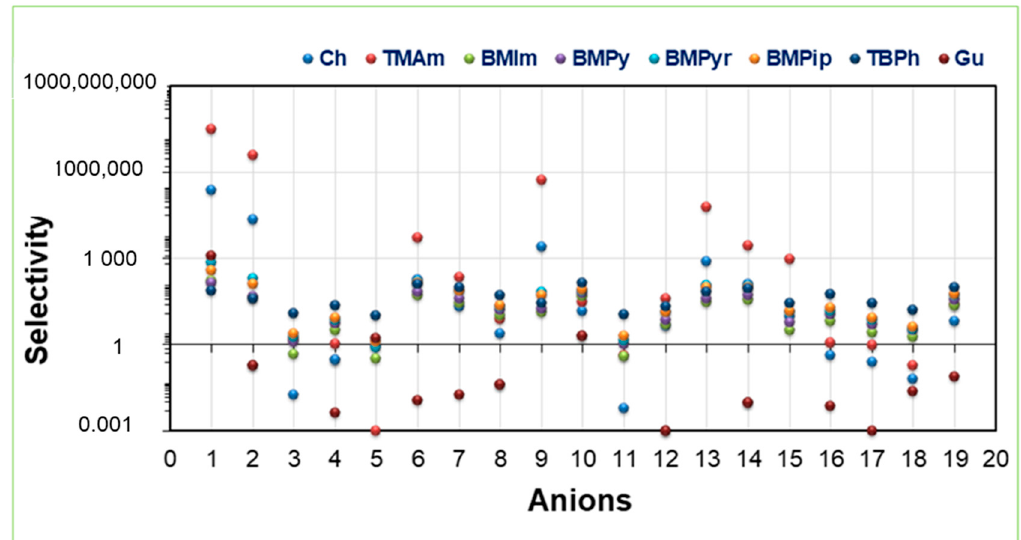
Figure 5. Selectivity of the studied ILs, using COSMO-RS .